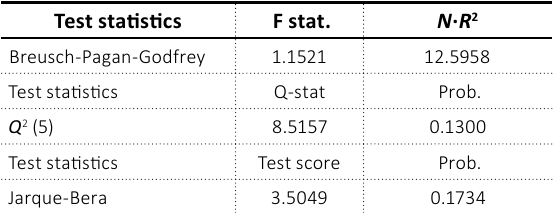
Table 7. Diagnostic test results